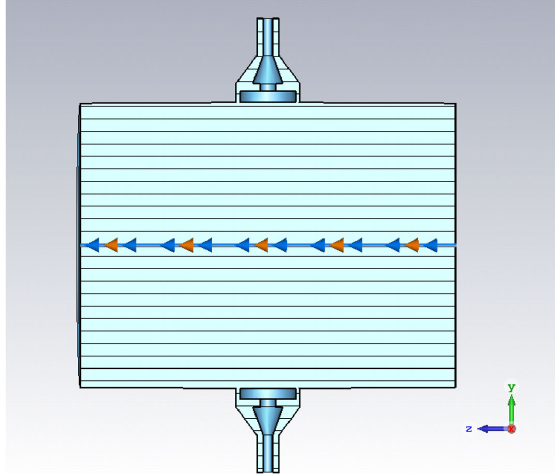
FIG. 17. Longitudinal cut of the four-button BPM model used in CST .